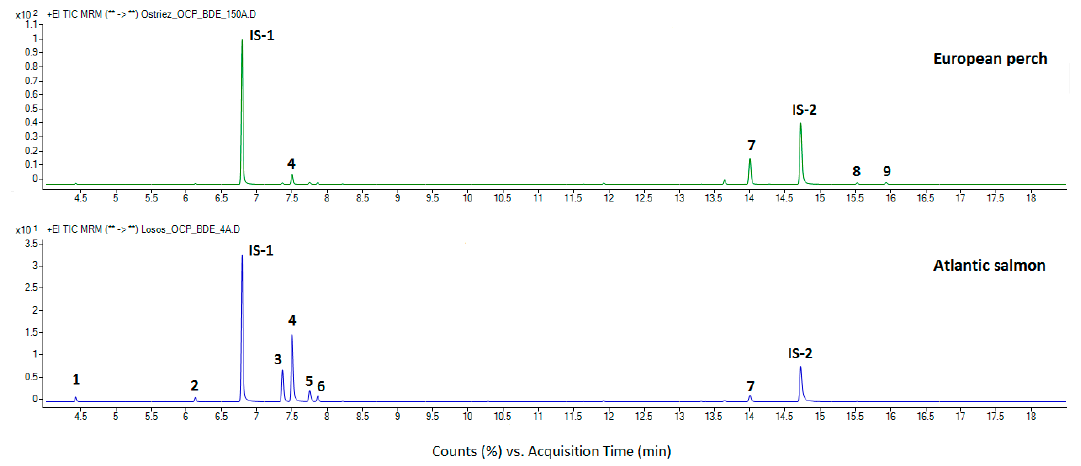
Figure 2. Total ion MRM chromatograms from the GC–QqQ-MS/MS analysis of extracts prepared from samples of European perch and Atlantic salmon. Peaks: 1—hexachloro-1,3-butadiene, 2— pentachlorobenzene, IS-1—tetrachloro- m -xylene, 3— alpha -HCH, 4—hexachlorobenzene, 5—beta-